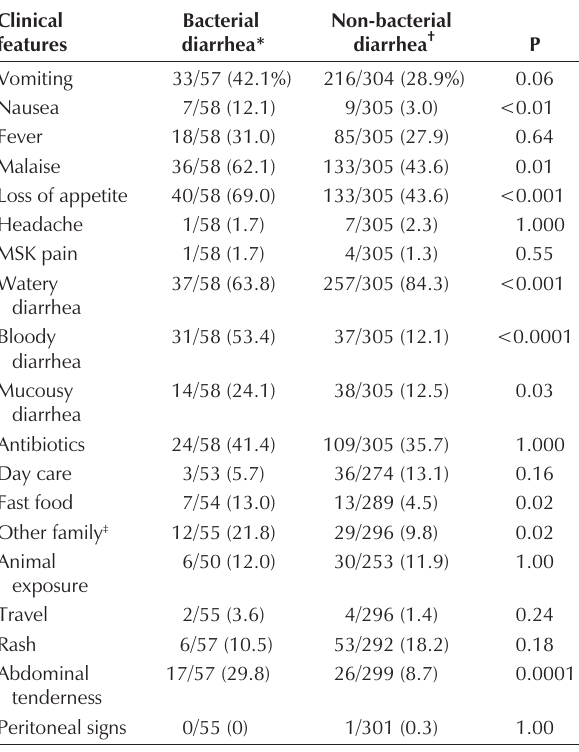
Clinical features of viral community-acquired diarrhea at the Alberta Children’s Hospital, Calgary, Alberta from April 1, 1993 to March 30, 1995